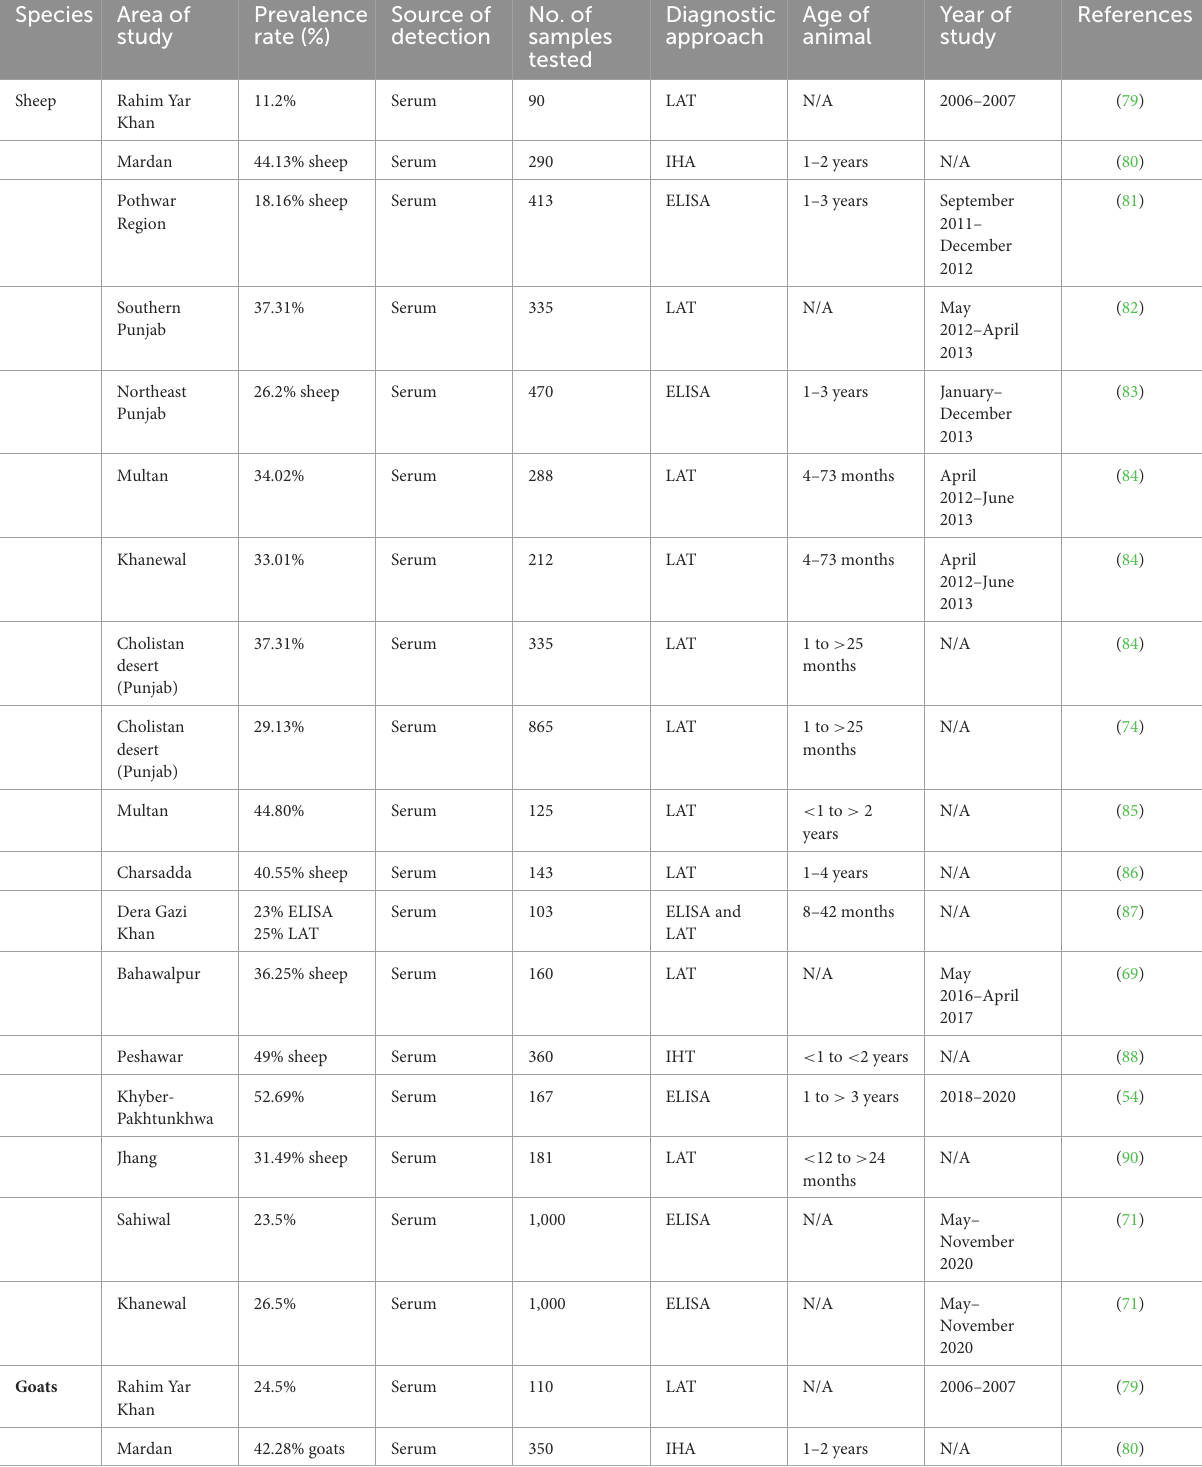
TABLE 3 Reported prevalence of Toxoplasma gondii in small ruminants (sheep and goats) in Pakistan. Species Area of